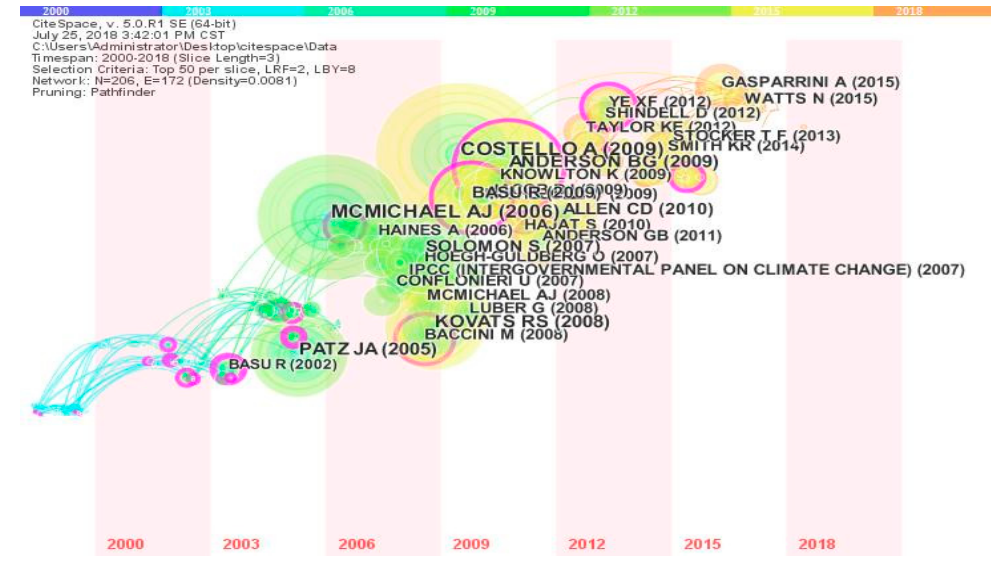
Figure 8. Article co-citation time zone diagram.